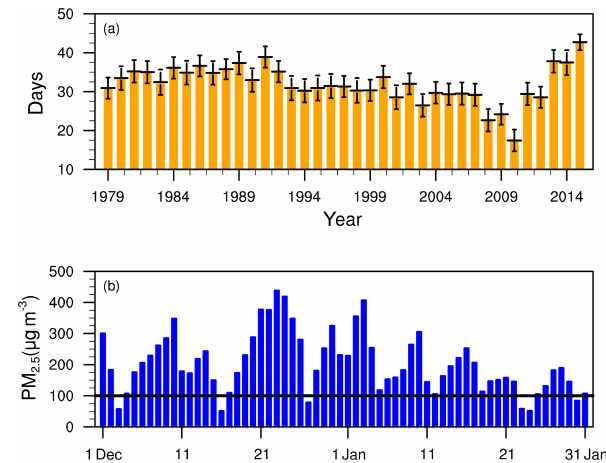
Figure 2. The variation of (a) HDJ NCP from 1979 to 2015 and (b) daily maximum PM 2 . 5 from December to January in 2015 over the NCP area. The error bars in panel (a) represent 1 standard error among the measured sites.